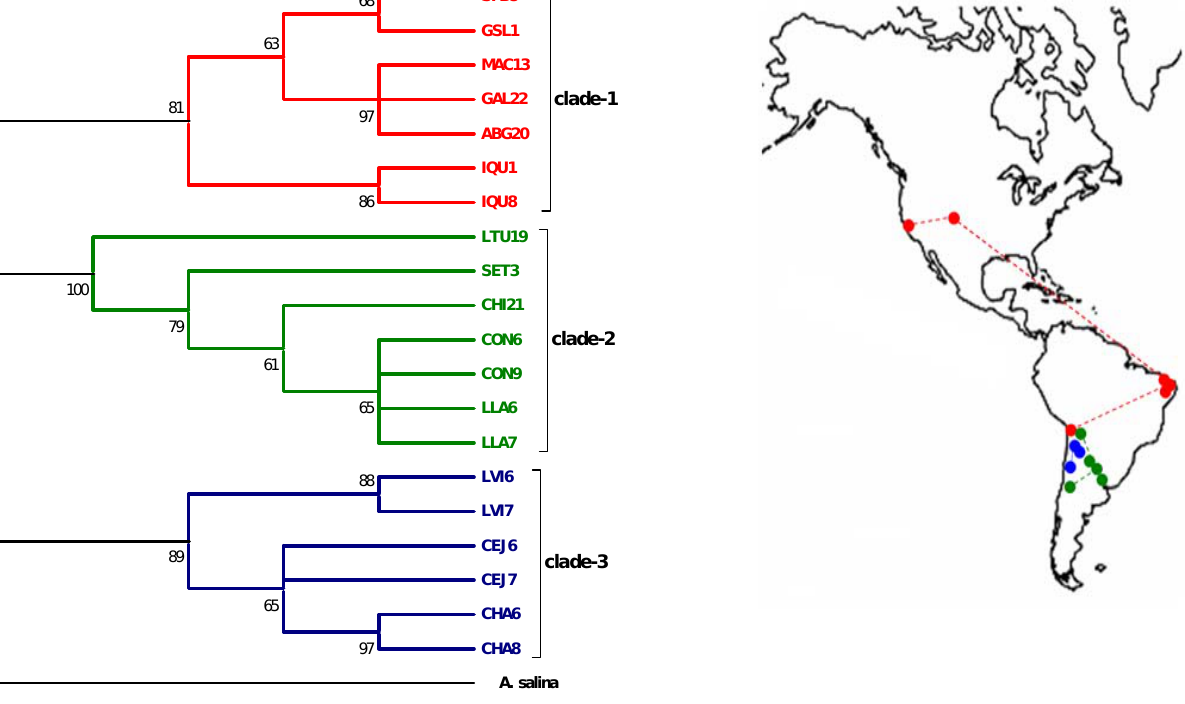
Figure 1. Consensus maximum parsimony phylogeny (50% majority rule of 124 most parsimonious trees, tree length = 230) of concatenated 16S and COI A. franciscana haplotypes. Values at nodes indicate bootstrap support based on 1000 pseudoreplicates. The geographic distribution of the recovered clades (connected by dashed lines for illustration purposes only) is shown on the map. The phylogeny is rooted with A. salina